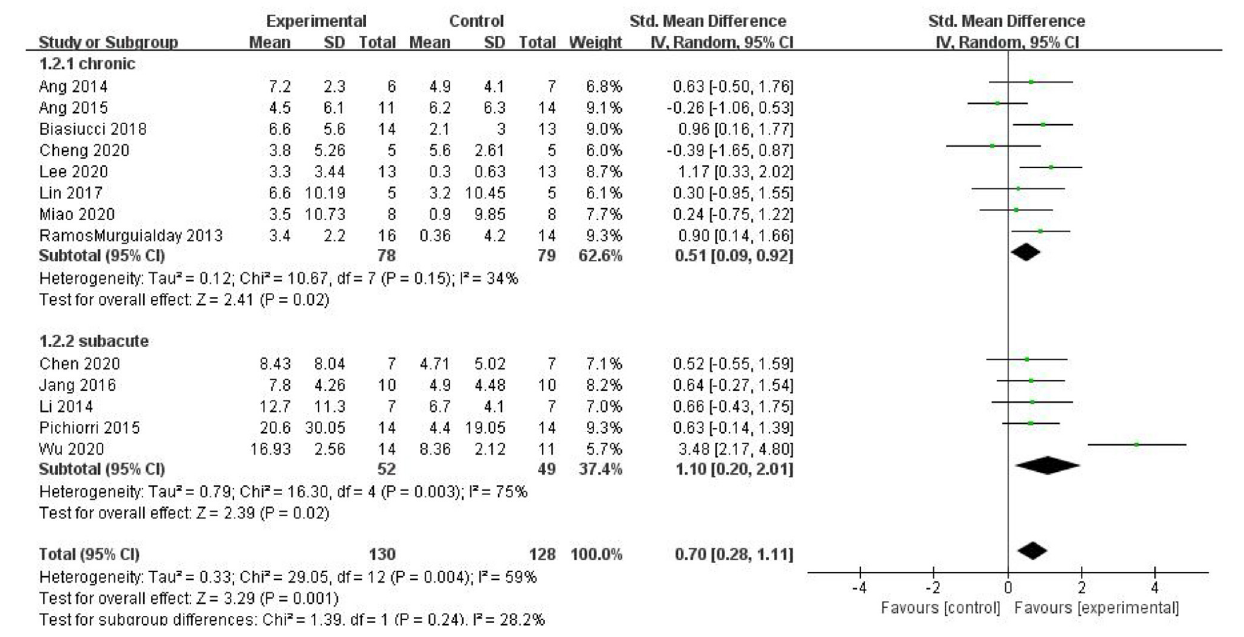
FIGURE 8 | A subgroup analysis of the effects of BCI on upper limb motor function in different intervention